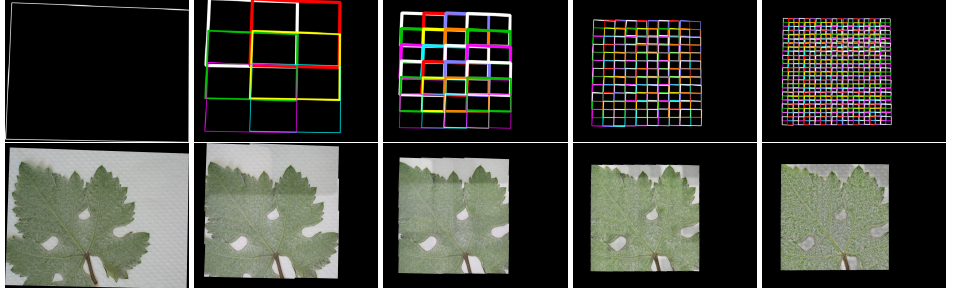
Figure 8. Scanned area and mosaics per pyramid